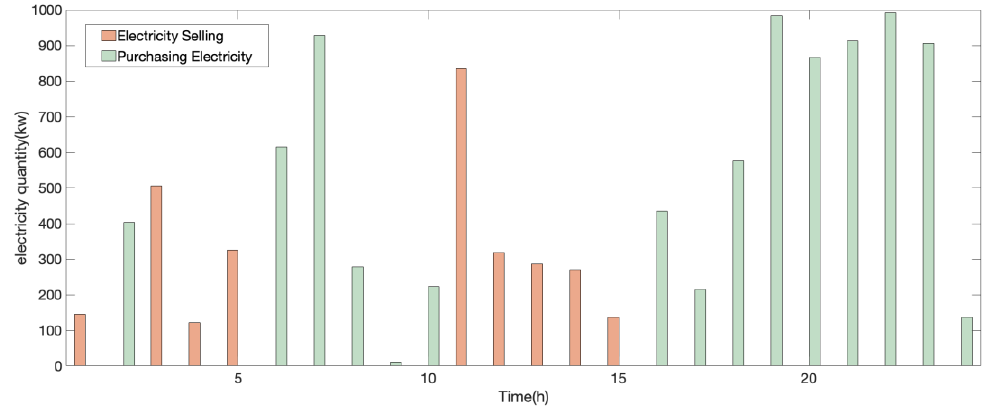
Figure 5. Bidding strategy of DERA without uncertainties.